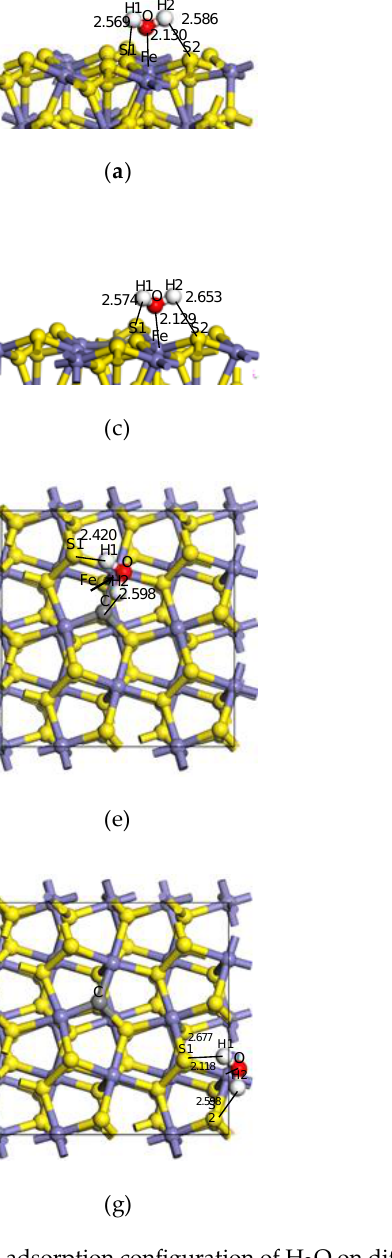
Figure 3. The adsorption configuration of H 2 O on different sites of the coal pyrite surface. Side view: ( a ) ideal surface; ( b ) doping-position; ( c ) ortho-position; Top view: ( d ) meta-position. ( e ) ideal surface; ( f ) doping-position; ( g ) ortho-position; ( h ) meta-position. Table 2. E ads of H 2 O on different sites of the pyrite surface with carbon defects. The adsorption configurations and adsorption energies of water molecules on the ideal pyrite Adsorption Configuration